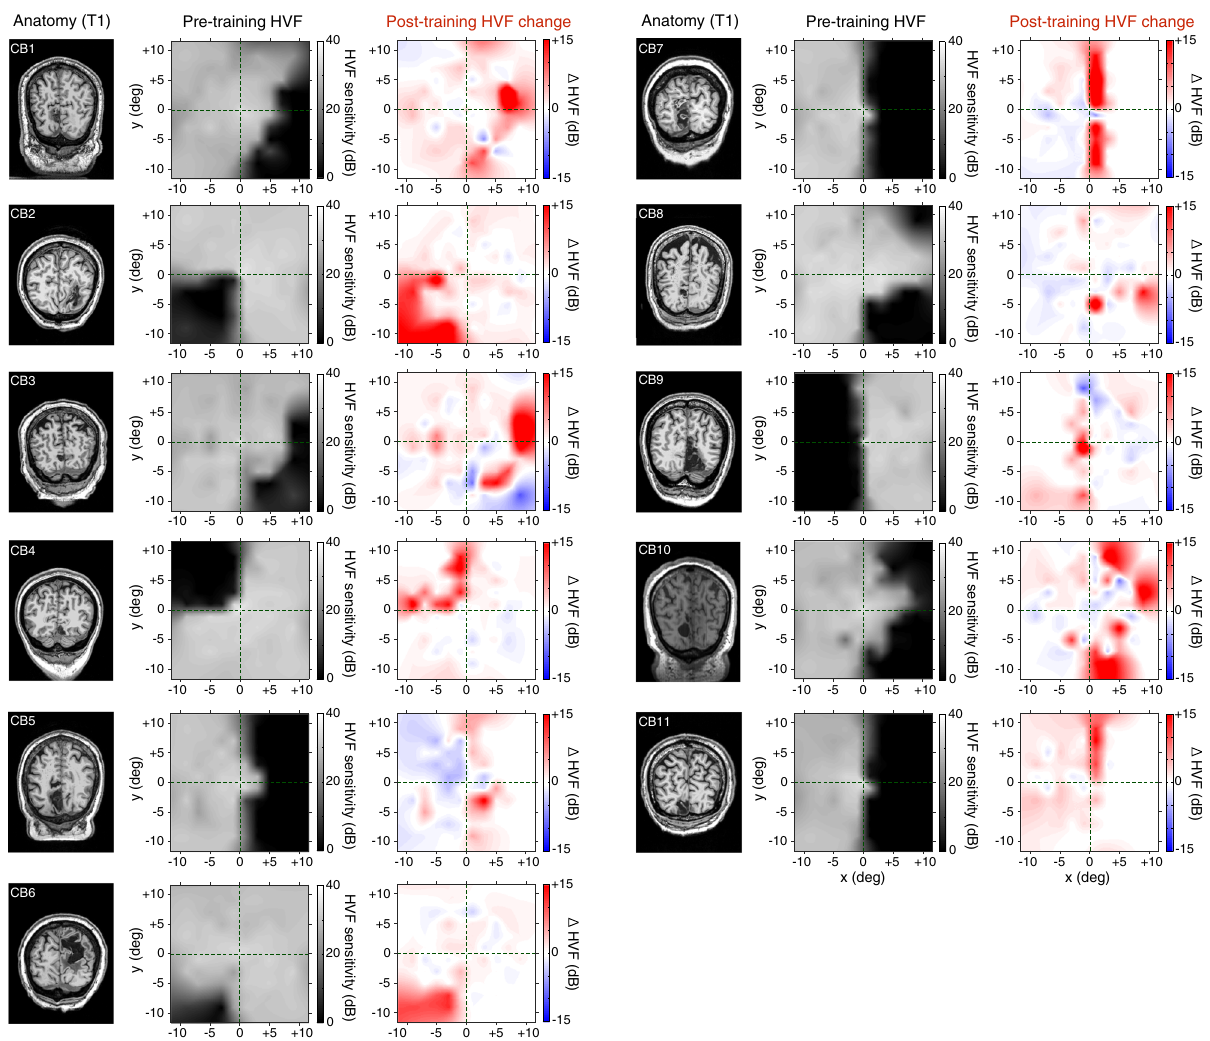
Fig. 2 Visual discrimination training improves conscious luminance detection sensitivity in chronic CB patients. T1-weighted MRI and corresponding baseline (pre-training) composite Humphrey Visual Fields (HVF; luminance detection sensitivity in dB) for all 11 chronic CB patients over the central 11.5 degrees of the visual fi eld – i.e., the area stimulated during fMRI retinotopic mapping (see Supplementary Fig. S1 for individual maps of the full HVFs showing locations used for visual discrimination training). Prior to training, all CB patients showed homonymous loss of HVF sensitivity (dark regions) within parts of their visual fi eld. As indicated by the post-training HVF change maps, all patients showed improved HVF sensitivity (red regions) following training, which was greatest within the con fi nes of their initial (pre-training) blind- fi eld border. A substantial amount of this recovery occurred within the inner 11.5 degrees of the visual fi eld (see 21 for full description of training-induced HVF recovery in a larger cohort of chronic CB patients). Areas of sensitivity loss (blue) were also noted in some patients, but only 2 (CB3 and CB9) exhibited signi fi cant loss ( ≥ -6dB) along with larger areas of HVF